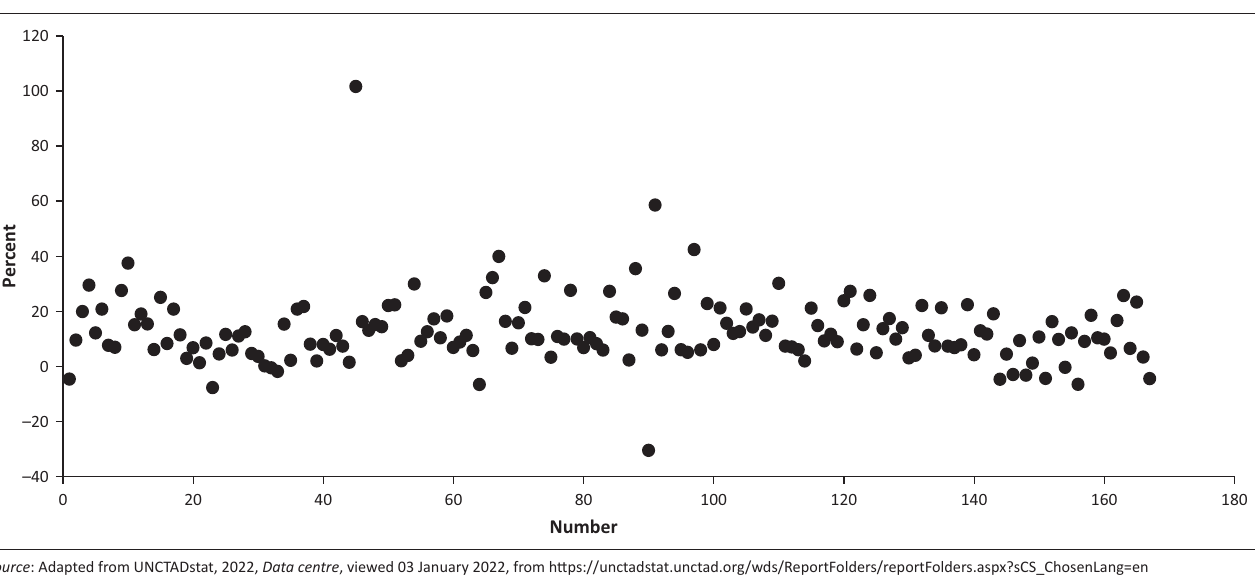
FIGURE 1: Pandemic impact on trade of sample